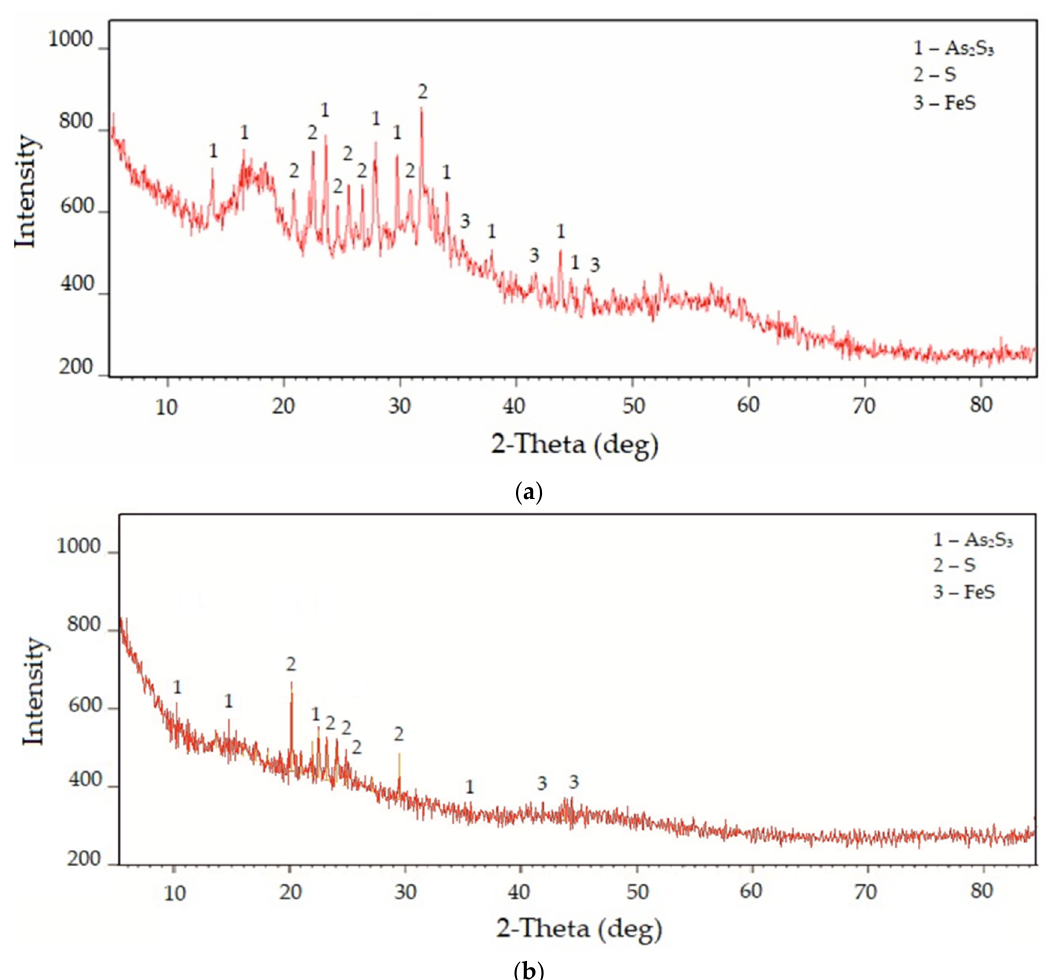
Figure 10. Diffraction pattern of the obtained precipitates of arsenic (III) sulphide with the introduction of As 2 S 3 seed crystal in the amount of 34 g/L ( a ) and without seed crystal introduction ( b ).